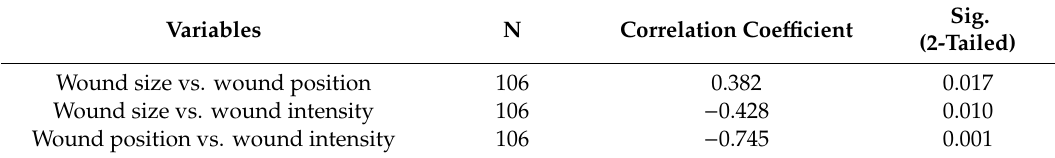
Table 3. Results of Spearman’s correlation analysis for wound characteristics.